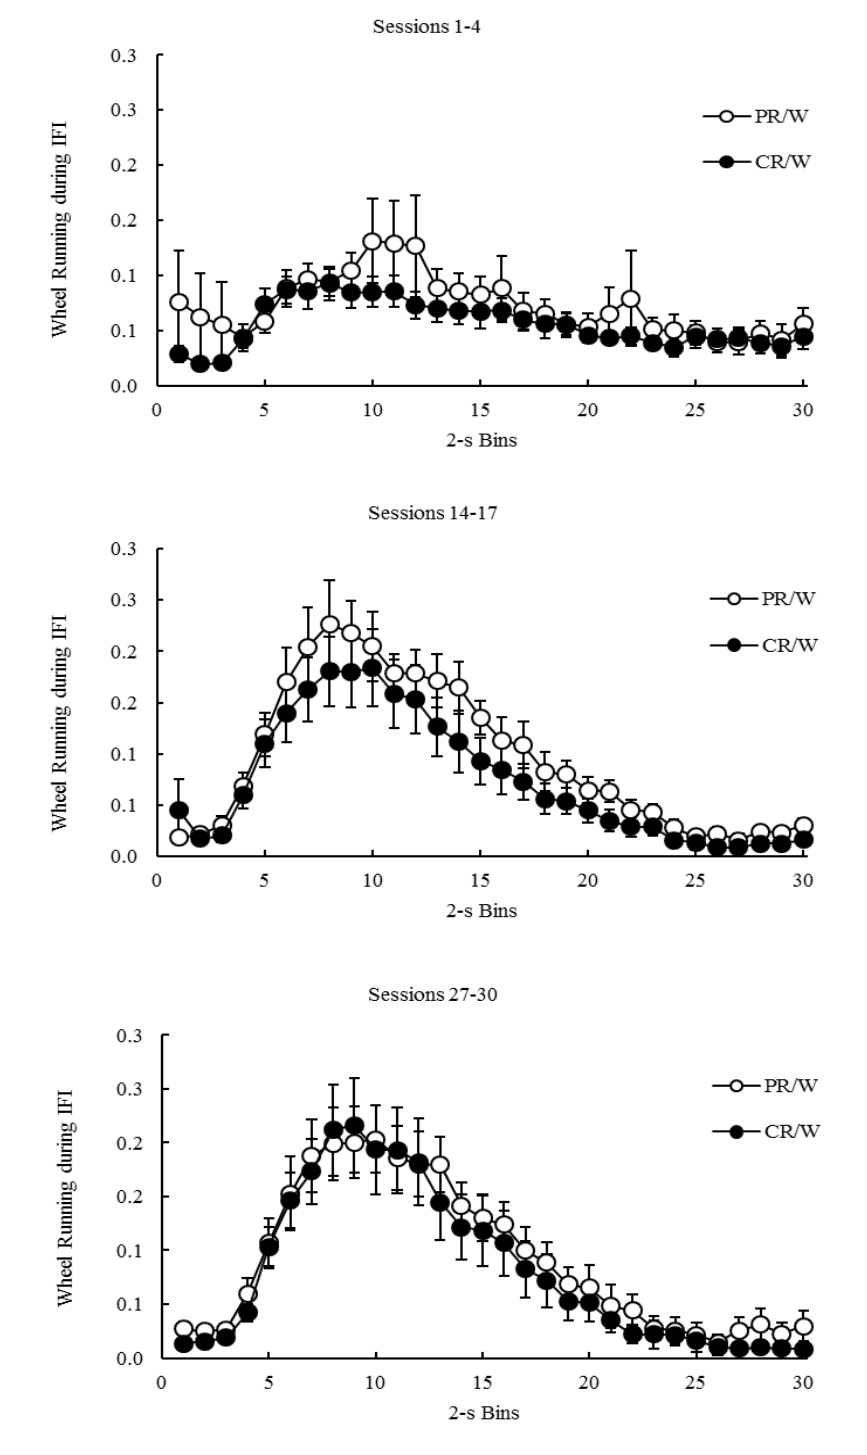
Figure 2. Mean (±SEMs) distribution of wheel running (in meters) within inter-reinforcement intervals plotted in 2 s bins for the initial, intermediate, and final sessions of exposure to the FT 60 s food delivery schedule, for the partial reinforcement (PR/W) and continuous reinforcement (CR/W) groups. PR: partial reinforcement; CR: continuous reinforcement; W: access to a wheel during intermittent reinforcement. Error bars were always included, but they are difficult to visualize in some